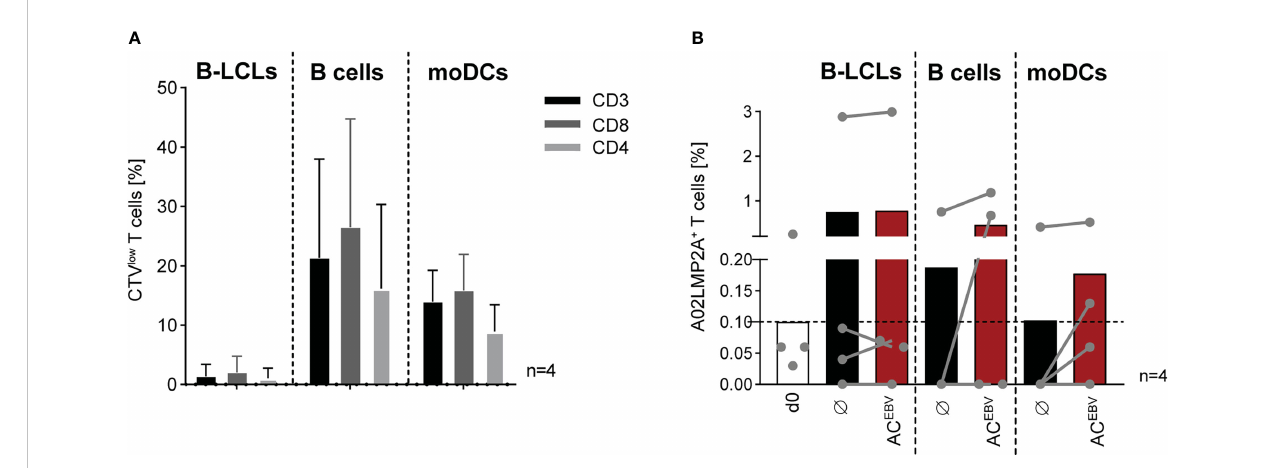
FIGURE 5 AC EBV -mediated long-term proliferation of EBV-speci fi c memory T cells. Frequency of (A) CTV low T cells (CD3, CD8, CD4) examined after seven days of stimulation with APCs loaded with the EBV antigen cocktail (AC EBV , E:T 10:1) and visualized after subtraction from those stimulated with unloaded APCs. Results of four independent experiments are expressed as mean ± SD. (B) Frequency of A02LMP2A + T cells in HLA-A*02:01 + , EBV- seropositive donors (n=4, grey dots) determined by A02LMP2A dextramer staining before and after stimulation (day 0/7). As control, unloaded APCs were co-cultured with autologous CD3 + T cells (Ø). Frequencies measured using a nonsense dextramer (background control) were subtracted. Results of four independent experiments are displayed as contiguous grey dots for individual donors and as mean values in response to unloaded and AC EBV -loaded. Statistical analysis was performed using the non-parametric Wilcoxon test. CTV, CellTrace